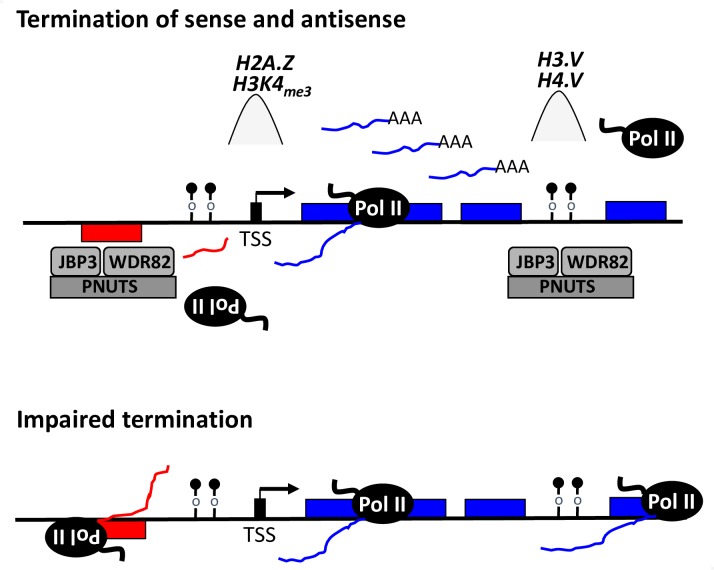
Regulation of termination by the PJW/PP1 complex in kinetoplastids.Schematic diagram of polycistronic RNA Pol II transcription. Transcription start sites (TSS), and direction of transcription, for the PTU on the top strand (blue genes) and bottom strand (red genes) are indicated by the black arrow. Peaks of histone variant (H2A.Z) and methylated histone H3 (H3K4me3) localized at TSS are indicated. According to the model, bi-directional transcription initiates at each TSS, but only the Pol II transcribing the ‘sense strand’ fully elongates and generates productive poly (A) mRNAs. Pol II terminates the 3’-end of the PTU marked with base J (ball and stick) and H3.V. In T. brucei, the PJW complex is recruited to the termination site via JBP3 recognition of J-DNA and somehow controls termination. In Leishmania, regulation of termination by the PJW/PP1 complex presumably involves dephosphorylation of the CTD of Pol II (as discussed in the text). While we propose a similar mechanism in T. brucei, these studies did not identify PP1 as a stable component of the PJW complex. The PJW complex is also recruited to the dSSR upstream of the TSS, leading to premature termination of antisense transcription. These short transcripts may be additionally targeted for degradation. Impaired termination, following mutation of the PJW complex, leads to readthrough transcription at the 3’- and 5’-end of PTUs. Genes located downstream of these termination sites, at the 3’- and 5’-end (upstream of the TSS) of a PTU, can generate stabilized polyA mRNAs and be expressed.